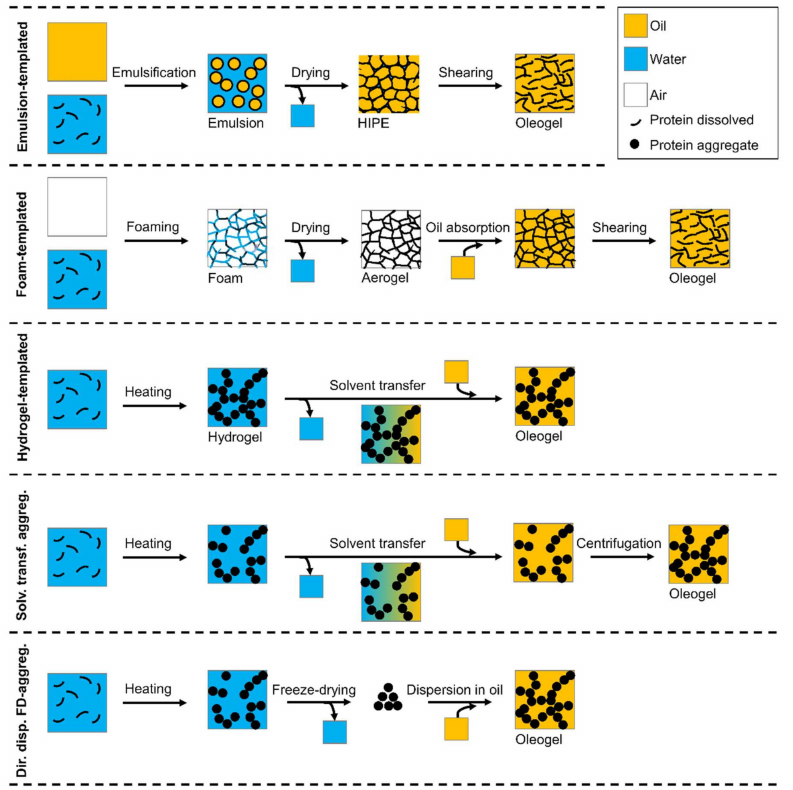
Figure 1. Schematic overview of the di ff erent methods for protein oleogel